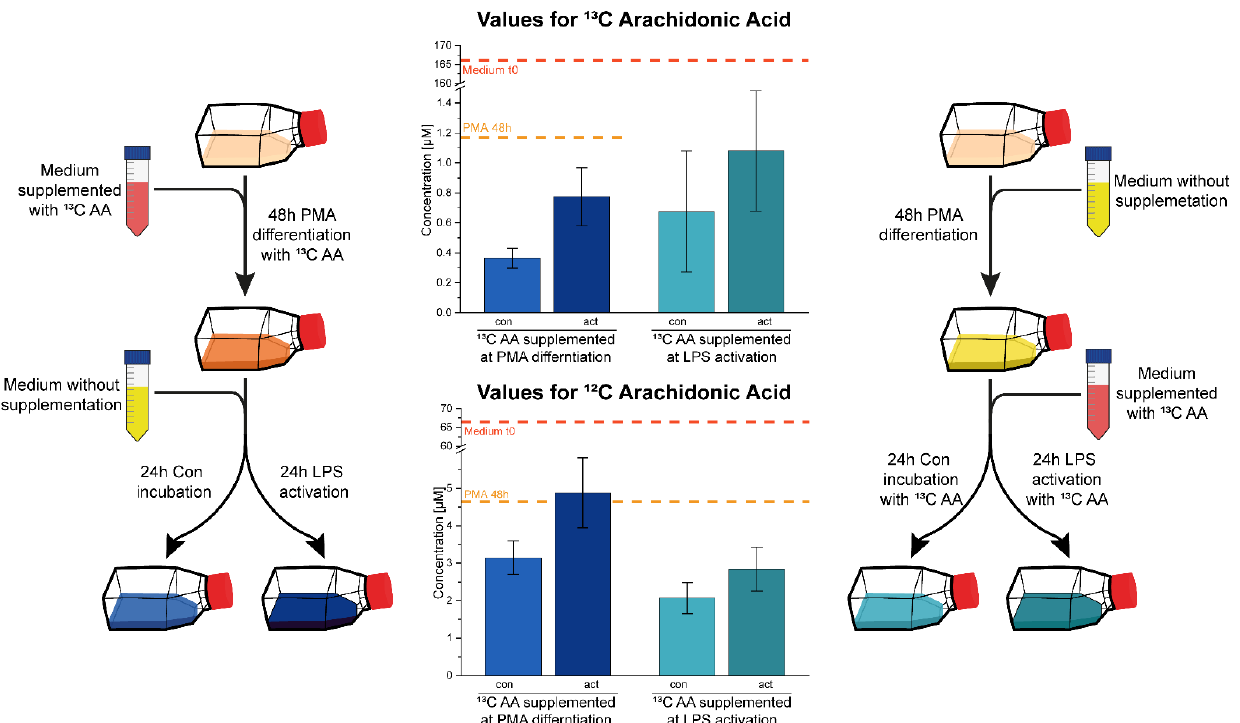
Figure 3. Experimental setup and results from AA spiking experiments. Medium was supplemented with 13C AA either before differentiation (left hand side) or before LPS treatment (right hand side). AA determination of cell supernatants by LC-MS/MS revealed AUC values as indicated. Medium levels at the beginning of cell culture are indicated by lines. Error bars are derived from three independent experiments. Con, untreated cells; act, LPS-treated cells. Note that AA concentration values strongly decrease upon cell cultivation but increase again upon LPS treatment.